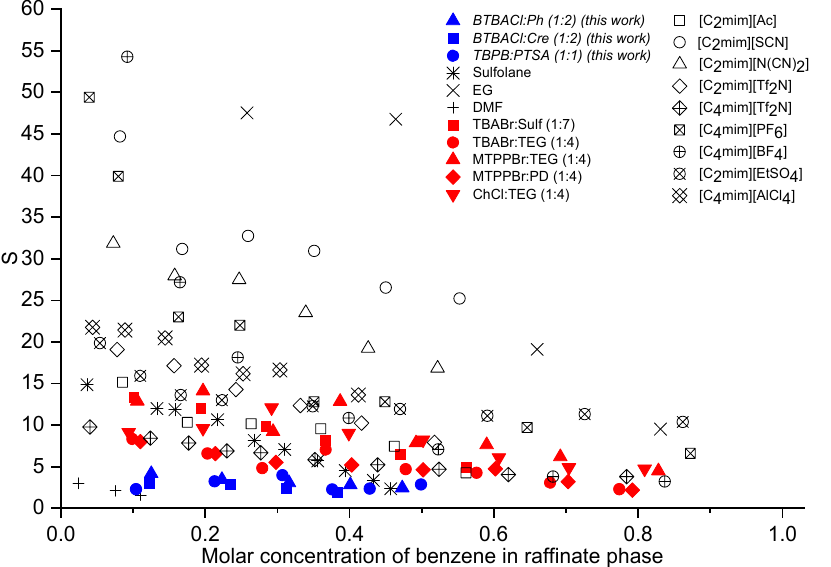
Figure 9. Selectivity of organic solvents, ILs, and ESs for the extractive separation of benzene and cyclohexane.